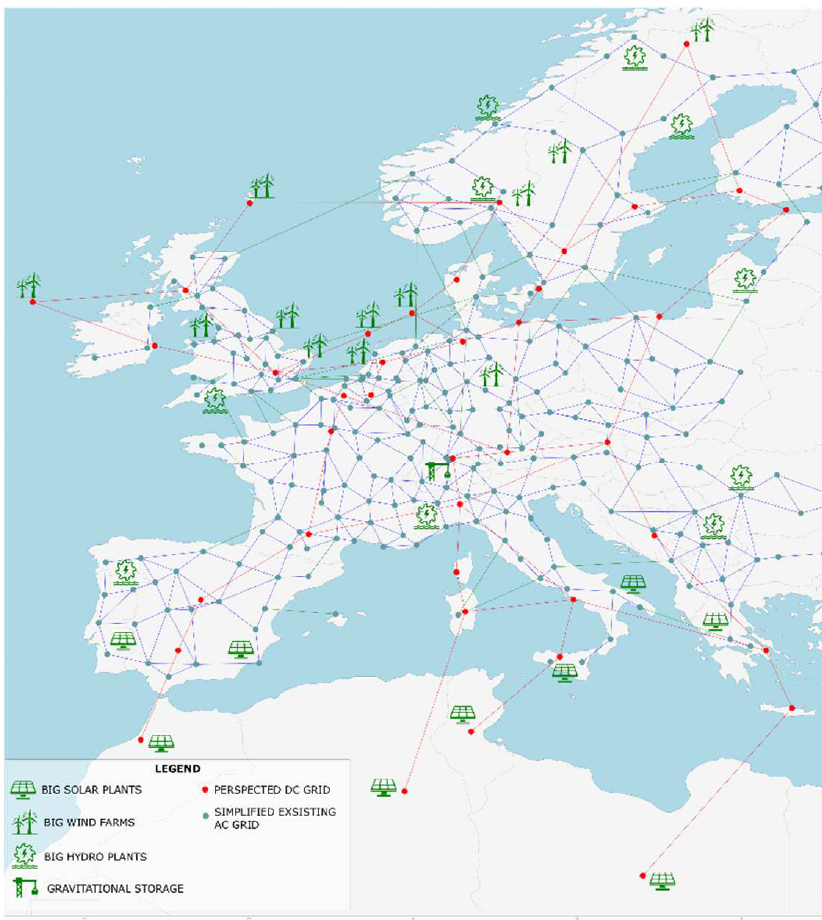
Figure 1. The integrated HVAC-HVDC Grid.